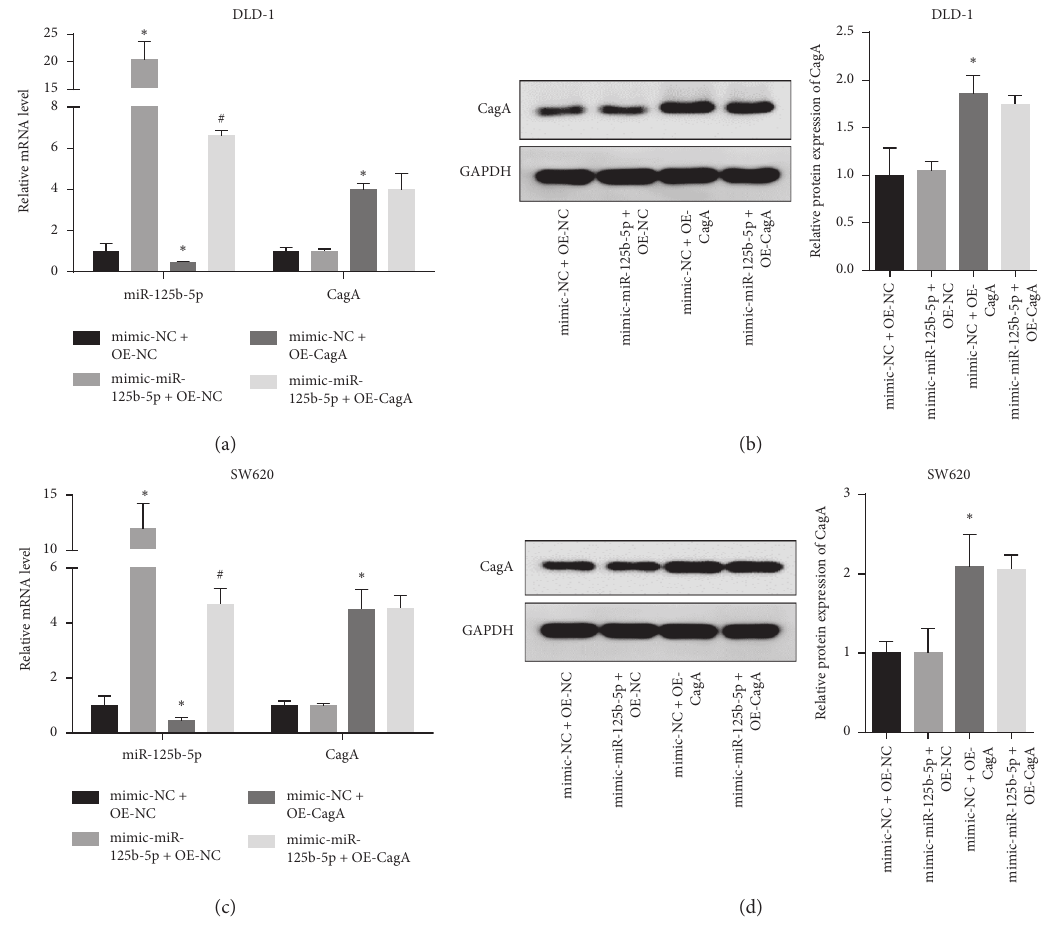
Figure 2: CagA overexpression inhibits miR-125b-5p, while miR-125b-5p does not affect CagA expression in DLD-1 and SW620 colon cancer cells. (a) and (c) represent the transfection of CagA plasmid decreased the miR-125b-5p level, while transfection of miR-125b-5p did not affect the CagA mRNA level in DLD-1 (a) and SW620 (c) cancer cell lines. (b) and (d) represent the transfection of miR-125b-5p did not affect the CagA protein level in DLD-1 (b) and SW620 (d) cancer cell lines. ∗ p < 0 . 05, compared with mimic-NC+ OE-NC, and # p < 0 . 05, compared with mimic-NC +OE-CagA